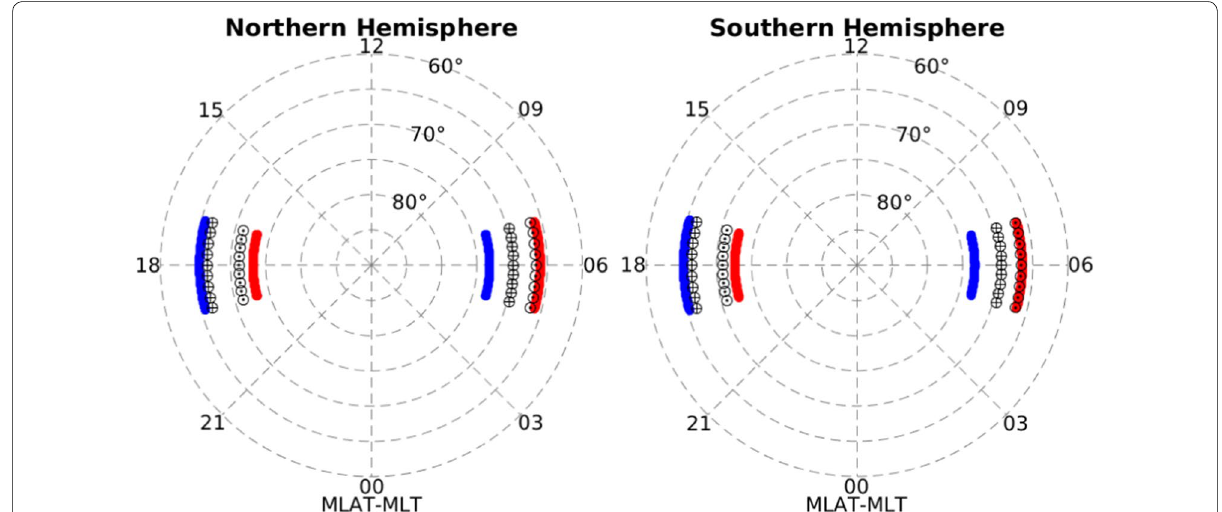
Fig. 9 The locations of the peaks of upward (red) and downward (blue) FACs, as well as the precipitation electrons (dot within black circle) and ions (cross within black circle) at dawn and dusk sides, and also in the two